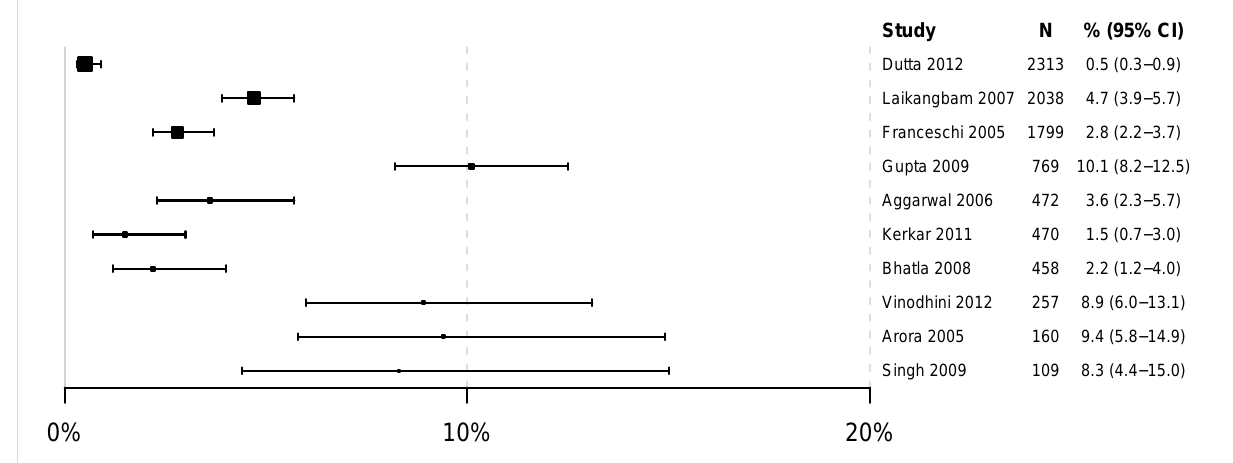
Figure 56: HPV 16 prevalence among women with normal cervical cytology in India, by